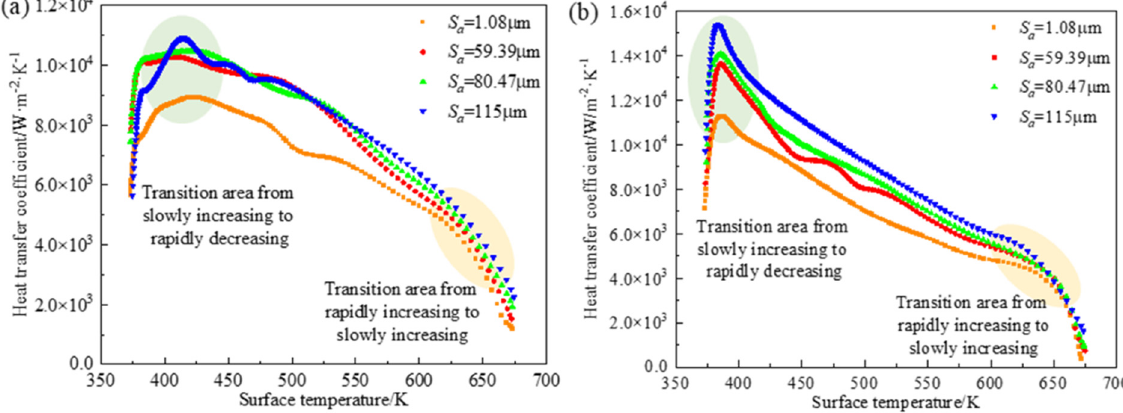
Figure 10. The relationship between HTC and surface temperature of the ingot with different surface